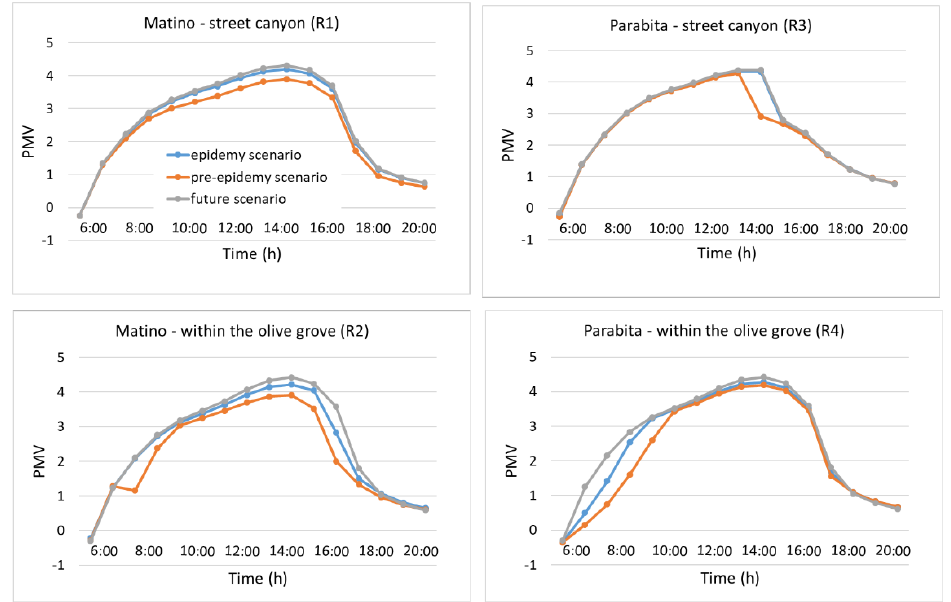
Figure 8. Predicted mean vote (PMV) hourly profiles for Matino (left) and Parabita (right) inside the street canyon (top) and within the olive grove (bottom) (see Figure 3 for the position of R1, R2, R3 and R4 receptors).